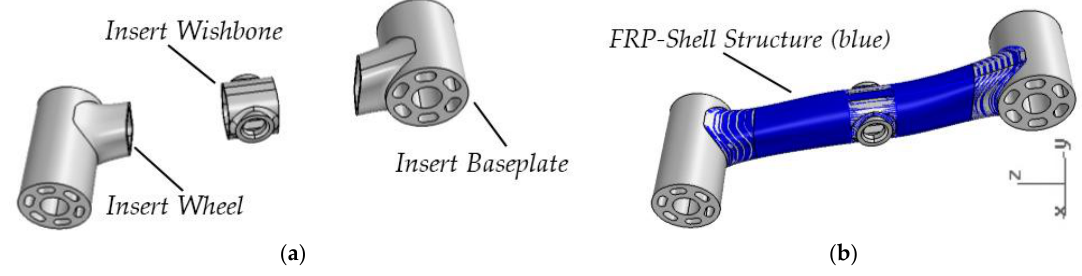
Figure 3. Design of inserts ( a ) and FRP shell structure ( b